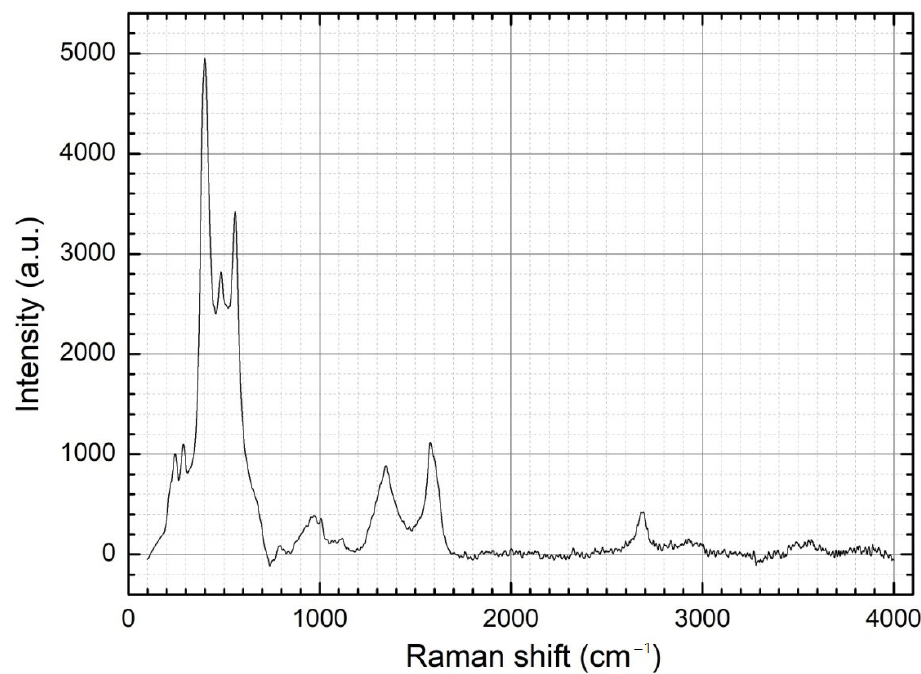
Figure 8. Raman spectra of the coagulum.